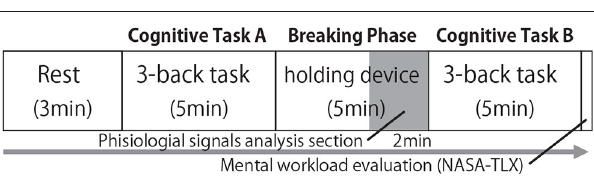
FIGURE 6 | Flow of experimental trial. This process was considered as one trial, and each of the seven conditions was trailed